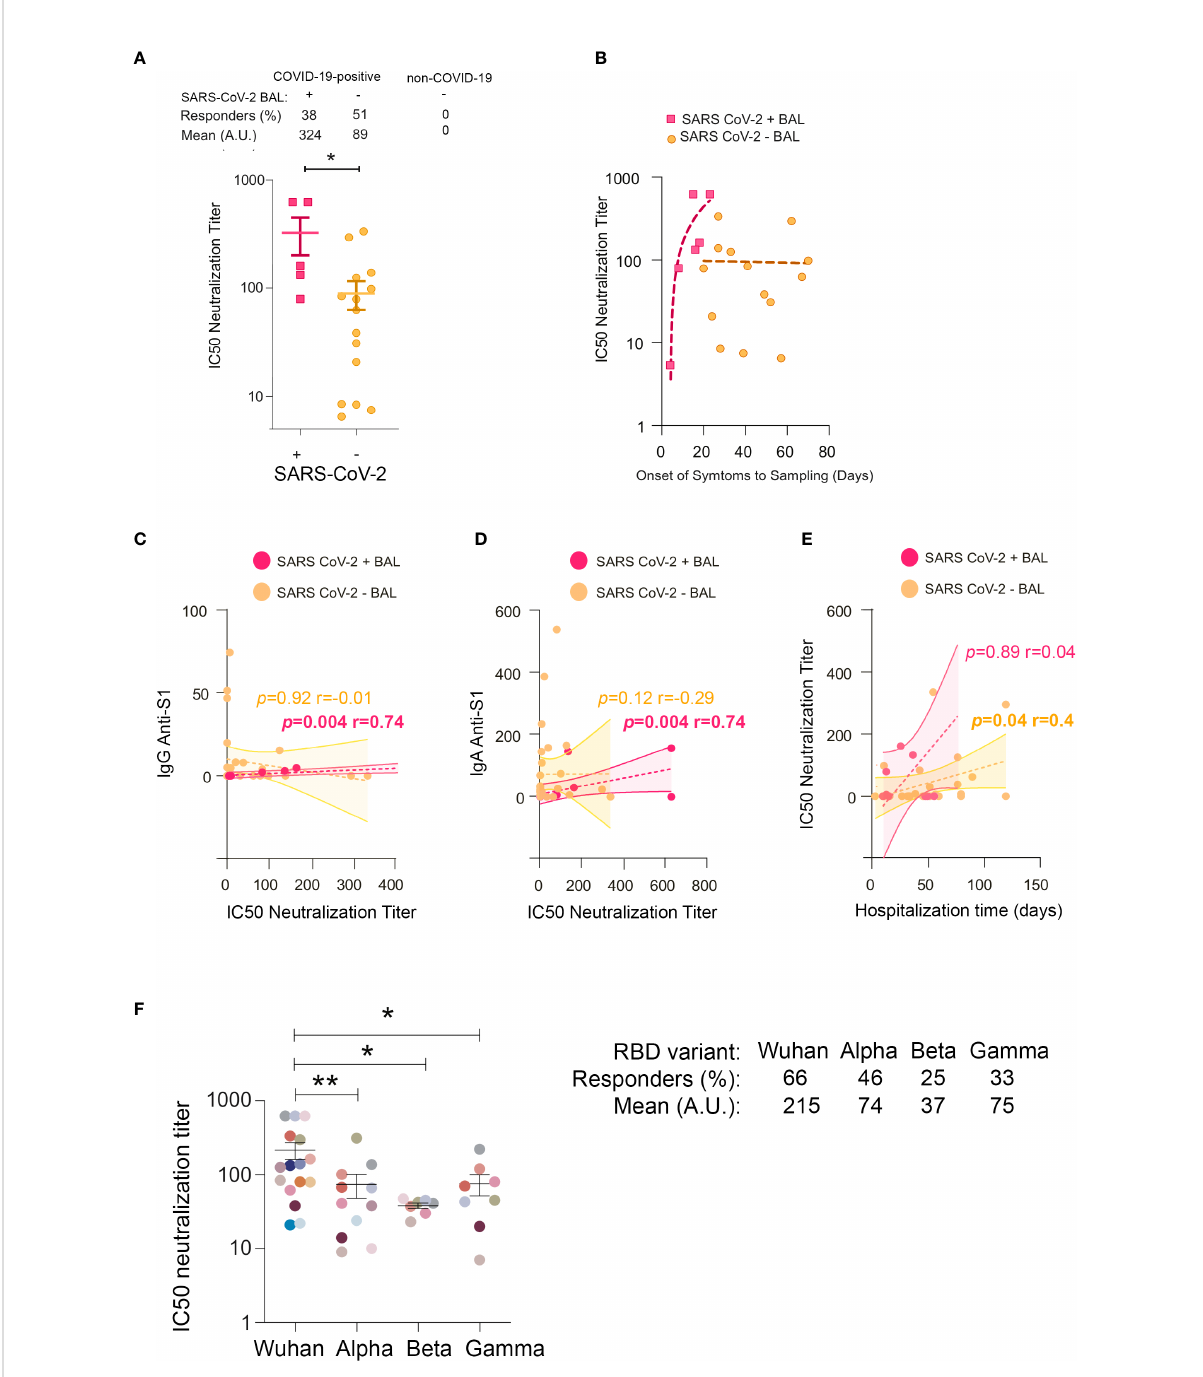
FIGURE 5 IC50 neutralization titers in BAL from COVID-19 individuals. (A) Comparison of IC50 neutralization titers between SARS-CoV-2+ BAL and SARS- CoV-2 − BAL samples. (B) Correlations between IC50 neutralization titers and the onset of symptoms to sampling date in SARS-CoV-2+ BAL (light blue squares) and SARS-CoV-2 − BAL (purple dots) individuals. (C) Correlation between IC50 neutralization titers and spike-speci fi c IgG in SARS-CoV-2+ and SARS-CoV-2 − BAL. (D) Correlation between IC50 neutralization titers and spike-speci fi c IgA in SARS-CoV-2+ and SARS- CoV-2 − BAL. (E) Correlation between neutralization activity and hospitalization time in SARS-CoV-2+ and SARS-CoV-2 − BAL. (F) IC50 neutralization titers of BAL from SARS-CoV-2+ individuals against ancestral Wuhan, and Alpha, Beta, and Gamma SARS-CoV-2 variants. A speci fi c color is associated with each individual. All correlations were calculated using Spearman ’ s test. p -Values were calculated by using Mann – Whitney test. *, p < 0.05; **, p < 0.01. BAL, bronchoalveolar